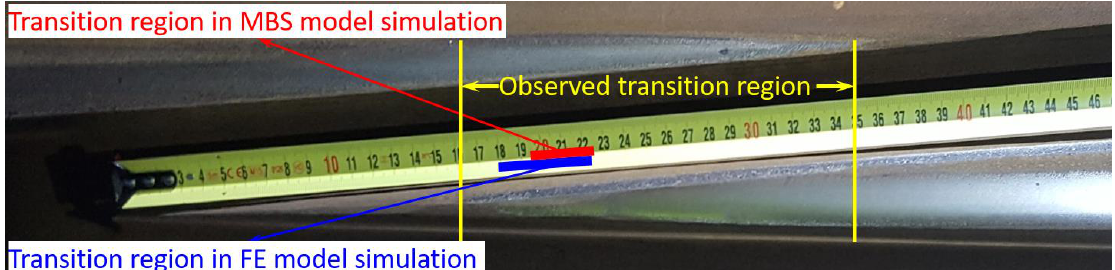
Figure 12. Transition regions obtained from the field observation and the numerical simulations. FE: finite element.